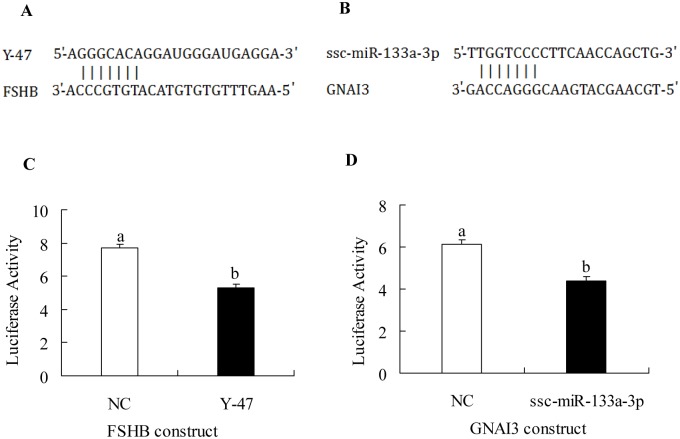
miRNA-mRNA interaction conformed by luciferase assay.(A) The second structure of Y-47(custom-designed miRNA) and its potential target FSHB (for seed sequence only). (B) The second structure of ssc-miR-133a-3p and its potential target GNAI3 (for seed sequence only). (C)Y-47 mimics significantly decreased FSHB construct luciferase activity (relative, firefly luciferase activity/Renilla luciferase activity). (D) ssc-miR-133a-3p mimics significantly decreased GNAI3 construct luciferase activity (relative, firefly luciferase activity/Renilla luciferase activity). Statistical significance was determined by ANOVA, followed by Tukey’s multiple comparisons test, the panels with different letter were considered statistically significant (p<0.05).